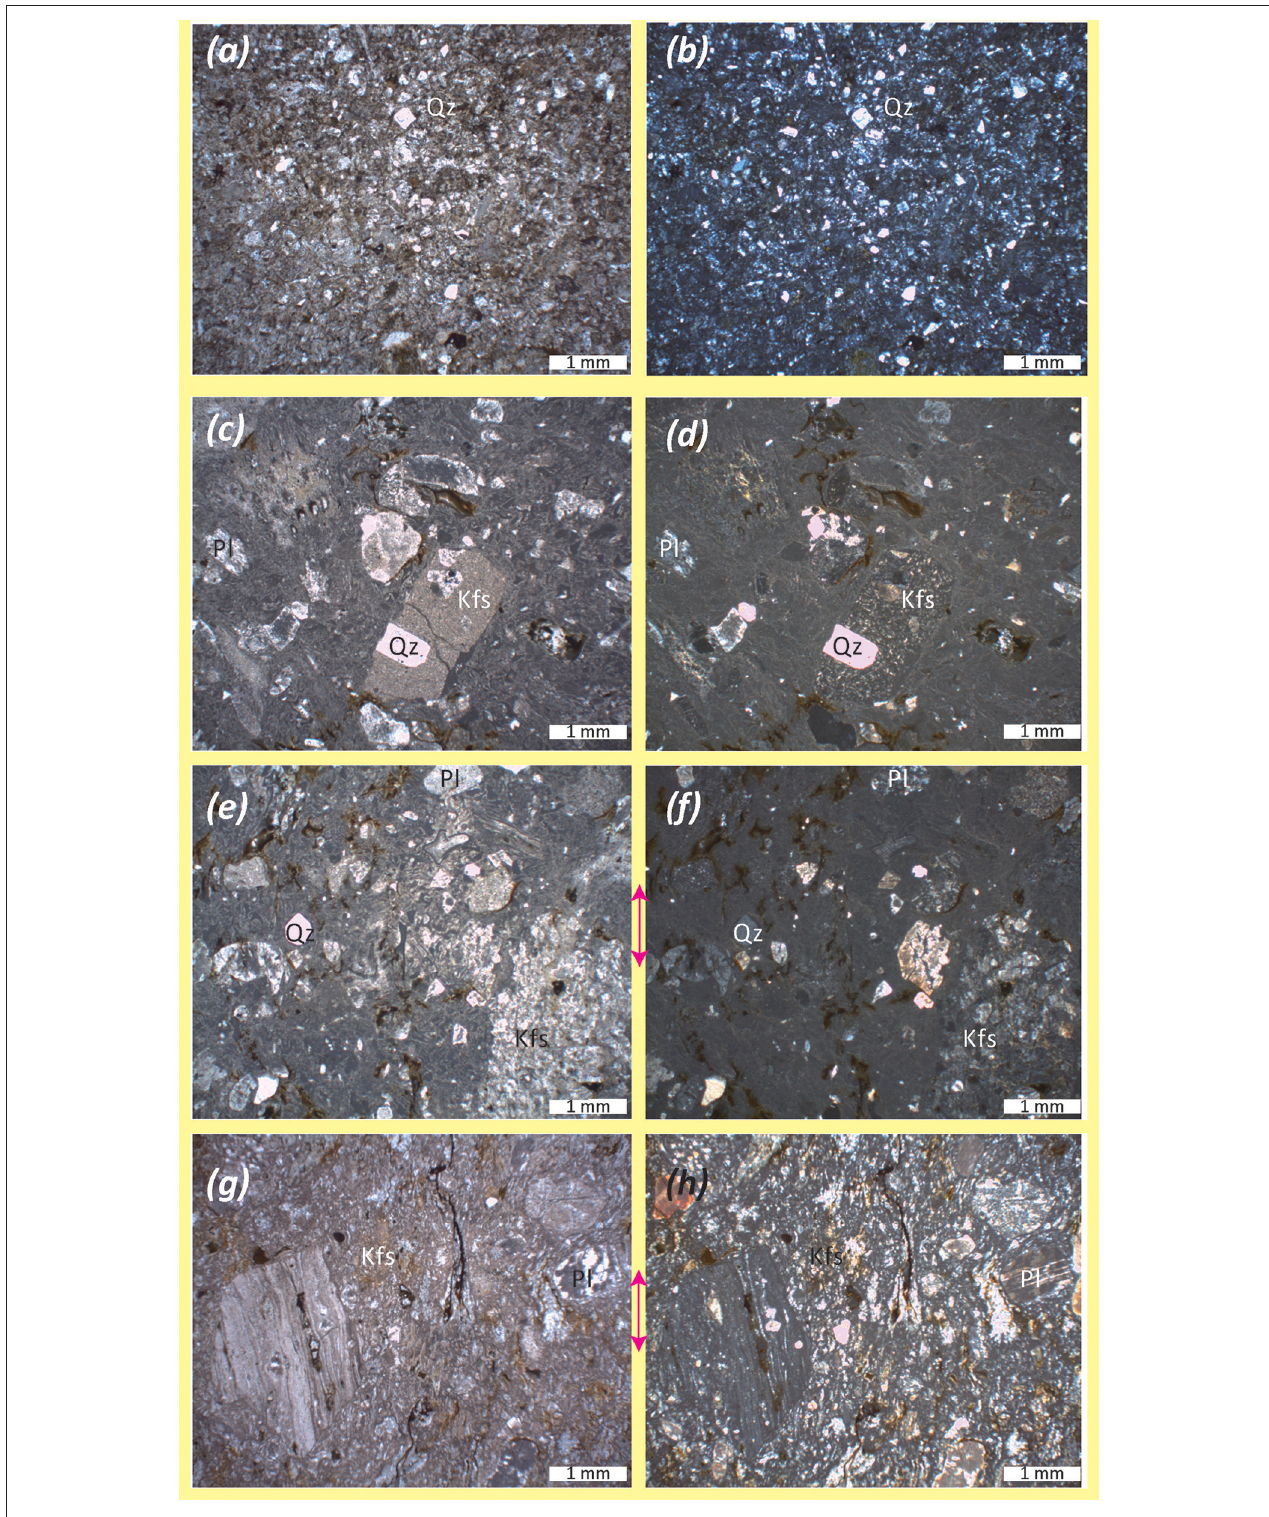
FIGURE 3 | Thin section images and microstructures of CVF. Kfs, K-feldspars; Pl, plagioclase feldspar; Qz, quartz; plain polarized light (left panel) and crossed polarizers (right panels). (A,B) Loosely welded tuff with lithic fragments in a matrix of devitrified shards. (C,D) Loosely welded pumice-rich tuff with feldspars